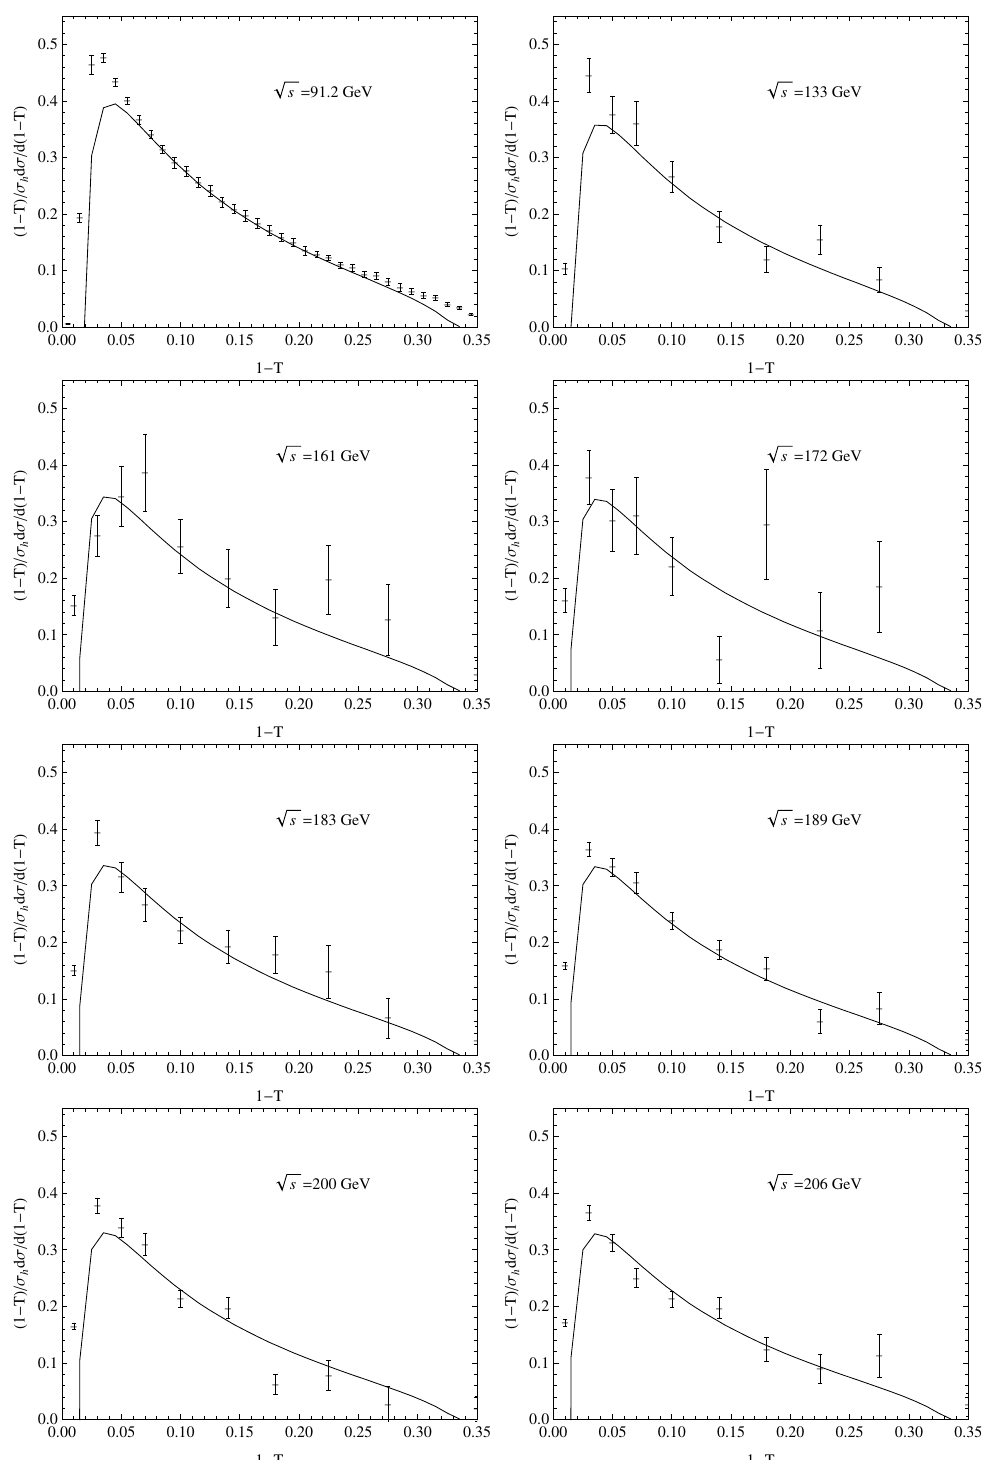
√ s = 91 . 2 , 133 , 161 , 172 ,